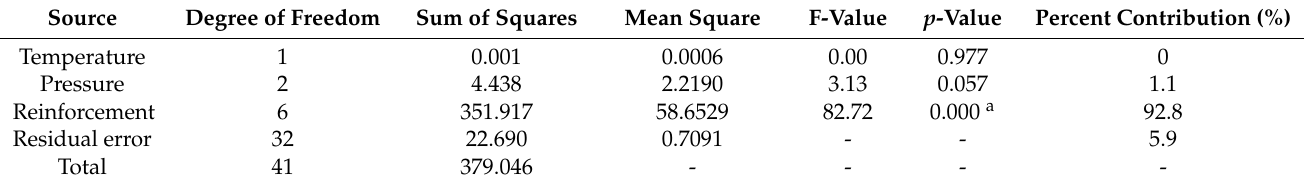
Table 7. Analysis of variance for S/N ratios of coefficient of